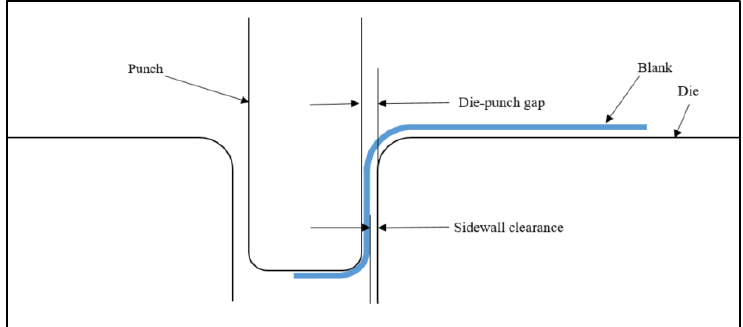
Figure 19. Representation of die-punch gap and sidewall